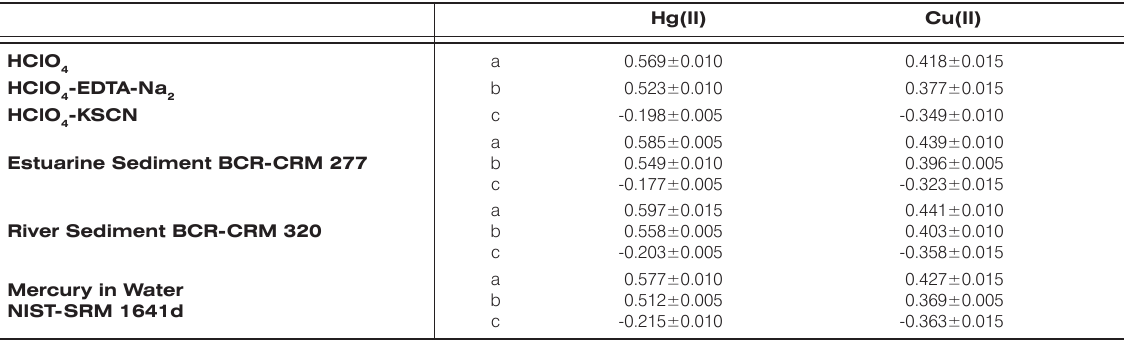
Table 2. Experimental peak potentials (E , V, Ag  AgCl  KCl ) for the aqueous reference solutions and for the standard reference material p sat. solutions. Number of independent determinations: 5.